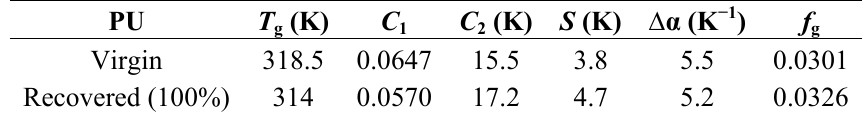
Table 5. The values of constants of WLF obtained by multi-frequency 3 point bending dynamic mechanical analyzer (DMA) test on polyurethane